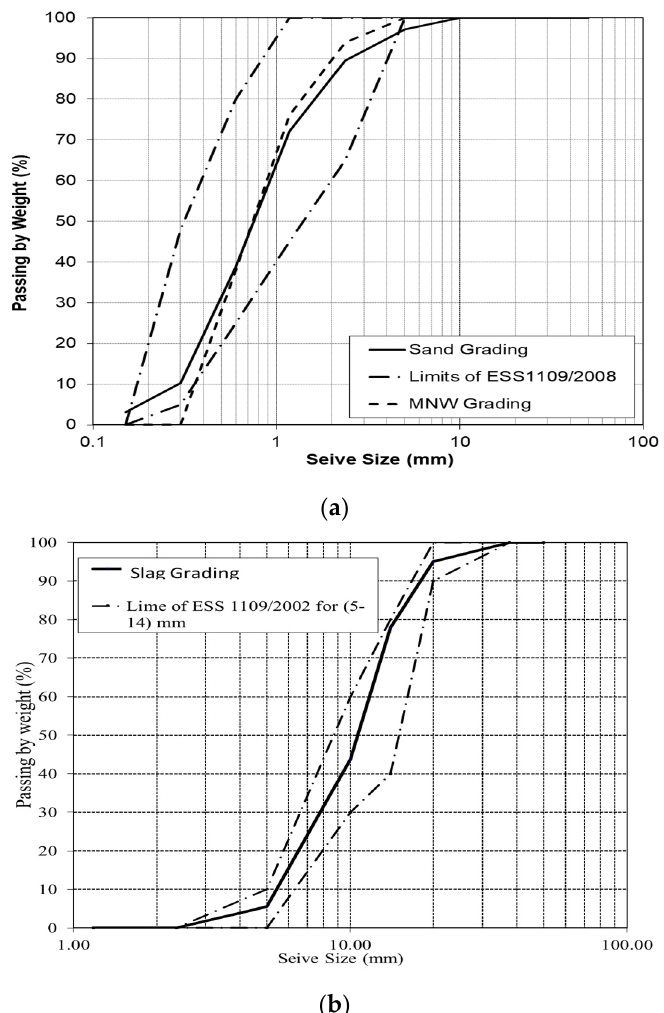
Figure 3. Sieve analysis of fine and coarse aggregates. ( a ) Fine aggregate (sand and MNW). ( b ) Coarse aggregate (EAFSS). Table 1. Physical properties of fine and coarse aggregates.